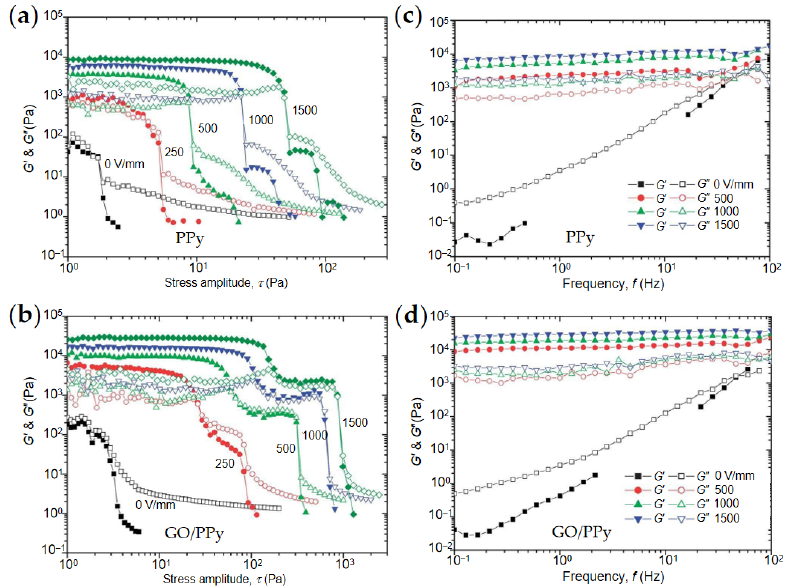
Figure 13. Storage modulus G' (solid points) and the loss modulus G “ (open points) as a function of oscillation stress ( a , b ), and storage modulus G' (solid points) and the loss modulus G “ (open points) as a function of frequency ( c , d ) for ER fluids: ( a ) PPy, ( b ) GO/PPy, ( c ) PPy, and ( d ) GO/PPy [84].